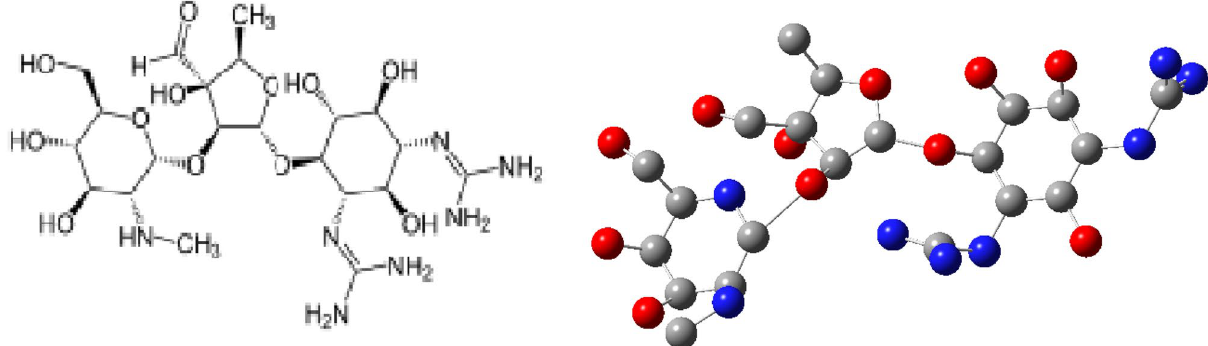
Figure 1. Schematic illustration of